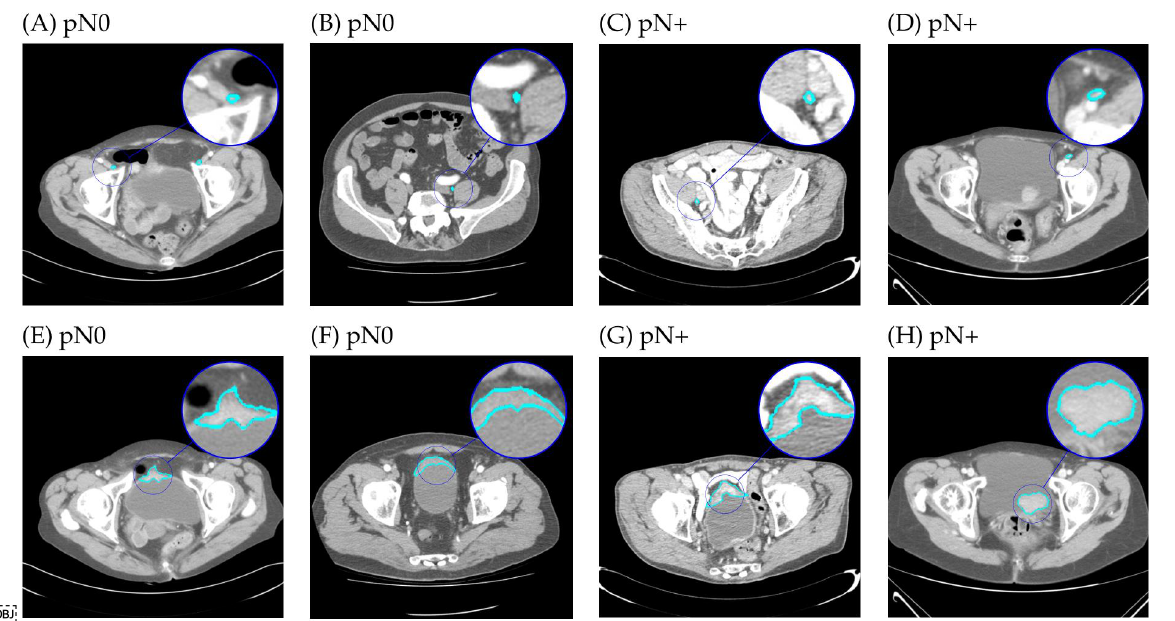
Figure 3. Randomly selected example segmentations on computed tomography scans of four patients with muscle-invasive bladder cancer scheduled for radical cystectomy and pelvic lymph node dissection. Top row: segmentations of pelvic lymph nodes in four patients without (pN0) ( A , B ) and with (pN+) ( C , D ) nodal metastases at pelvic dissection. Bottom row: corresponding segmentations of the largest 2D axial cross-sectional area of the primary tumor ( E – H ).